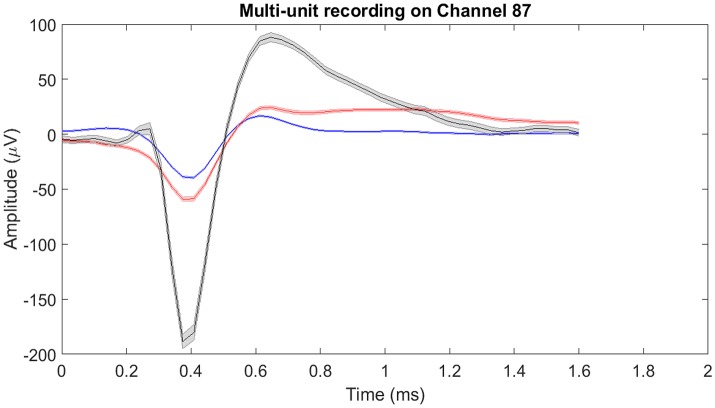
Mean of isolated single-units neural activity on Channel 87. Channel 87 contained three individual single-units post-spike-sorting. Since there was more than one single-unit recorded on channel 87, the single-unit and multi-unit firing rates were different. For single-unit firing rate, each single-unit was treated as an individual source of information. Whereas for multi-unit firing rate, the single-units were treated as one and the firing rate was computed. The shaded region around the mean action potential corresponds to the standard error of the action potential waveforms.